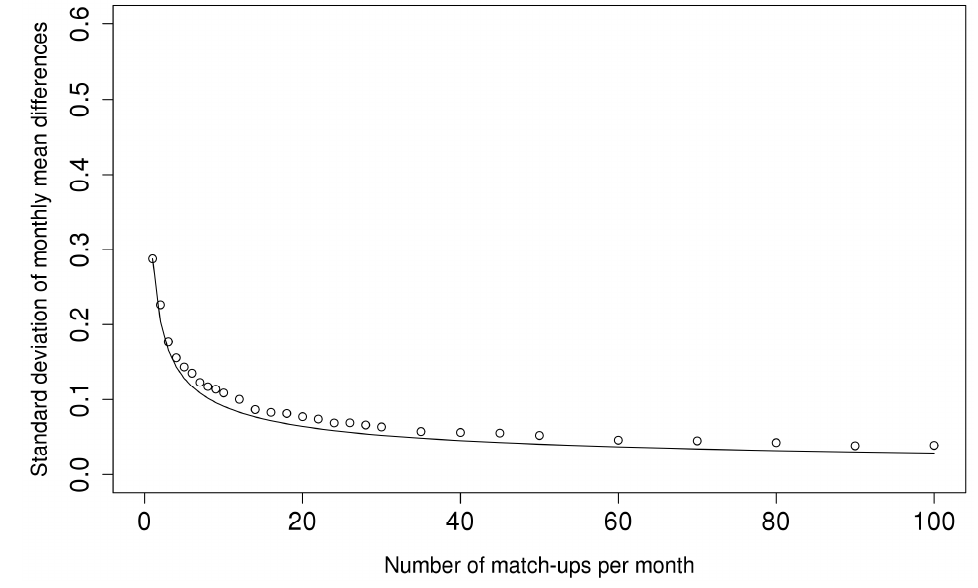
Figure 3. Standard deviation of monthly mean AATSR drifting buoy SST observations as a function of number of match-ups per month (dots). The theoretical relationship, σ √ , is also shown (solid line).